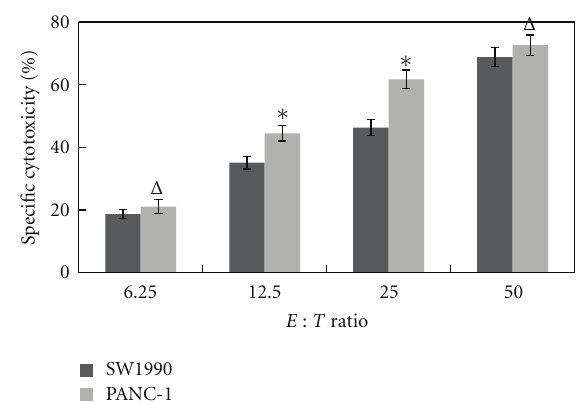
Figure 7: The cytotoxicity of K-ras-DCCIK against PANC-1 (K- ras + ) and SW1990 (K-ras − ) cells at di ff erent E : T ratio in vitro (experiment 2.7). It was found that when e ff ector-target ratio reached 1 :12.5 and 1 :25, K-ras-DCCIKs’ inhibition to PANC-1 was stronger than that to SW1990 ( ∗ P < 0 . 05). However, E : T